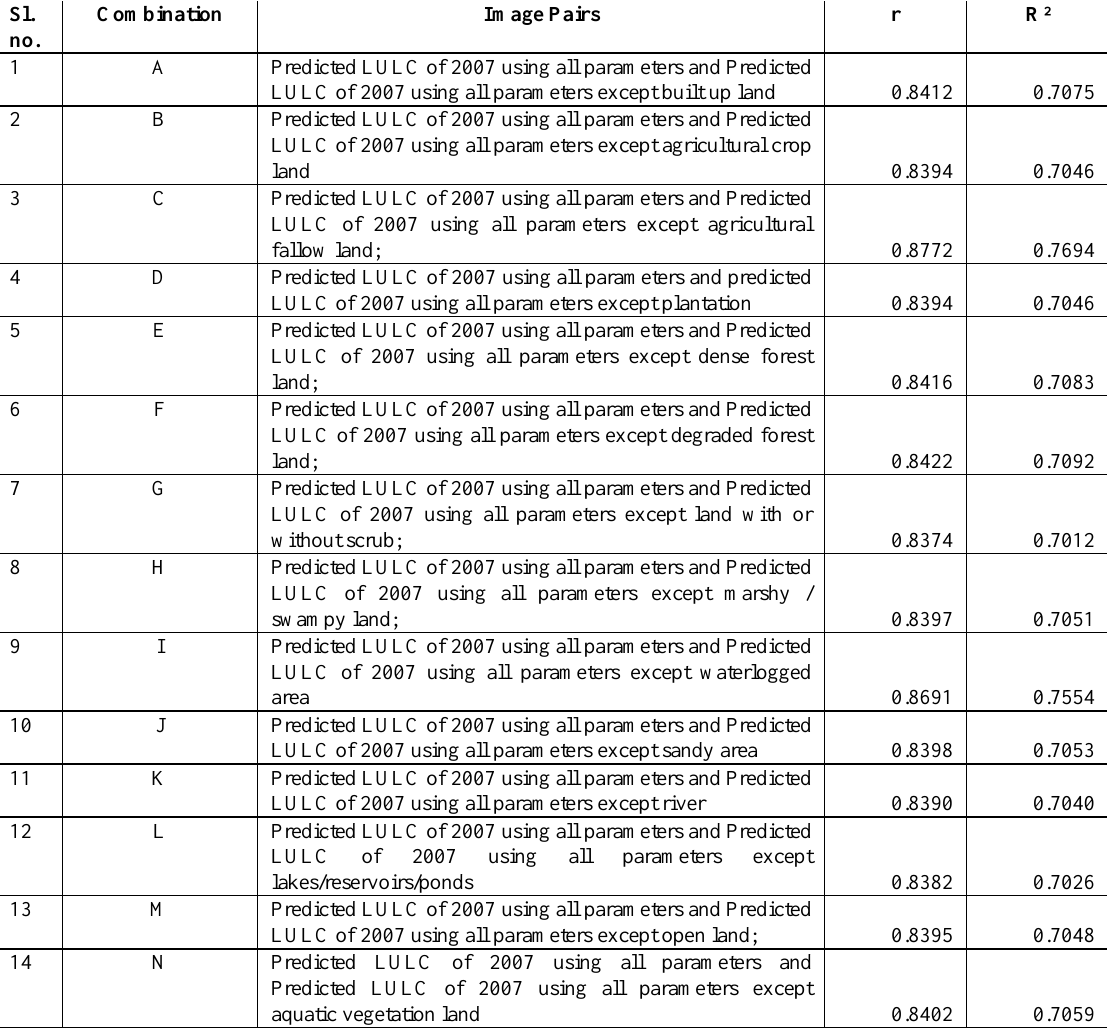
Appendix 1: Relationship between predicted LULC of 2007 using all parameters & predicted LULC of 2007 using all